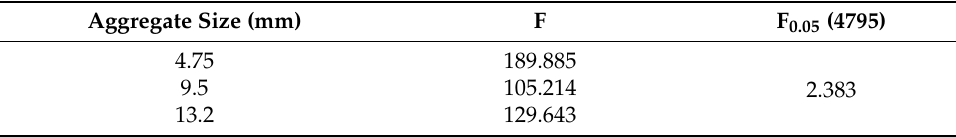
Table 4. Influence of mineralogical properties on aggregate texture